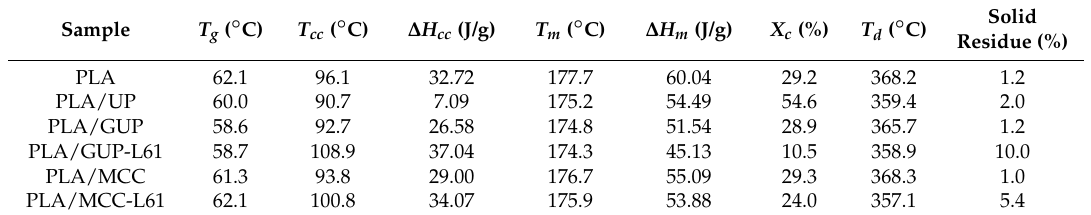
Figure 10. Polarized optical microscopy images of: ( a ) PLA/MCC and ( b ) PLA/UP biocomposite films (see Table 1 for sample identification).